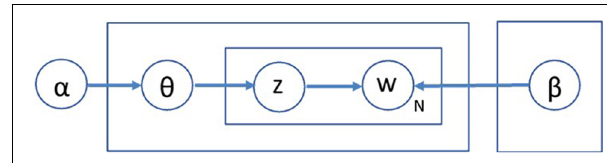
FIGURE 3 | Plate notation representing LDA.